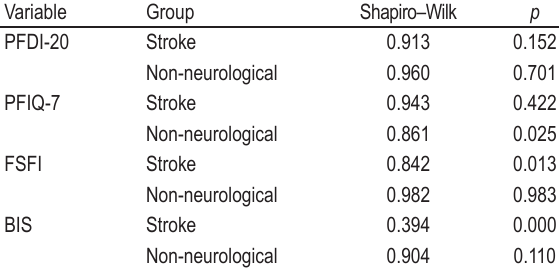
TABLE 1. Shapiro–Wilk test of